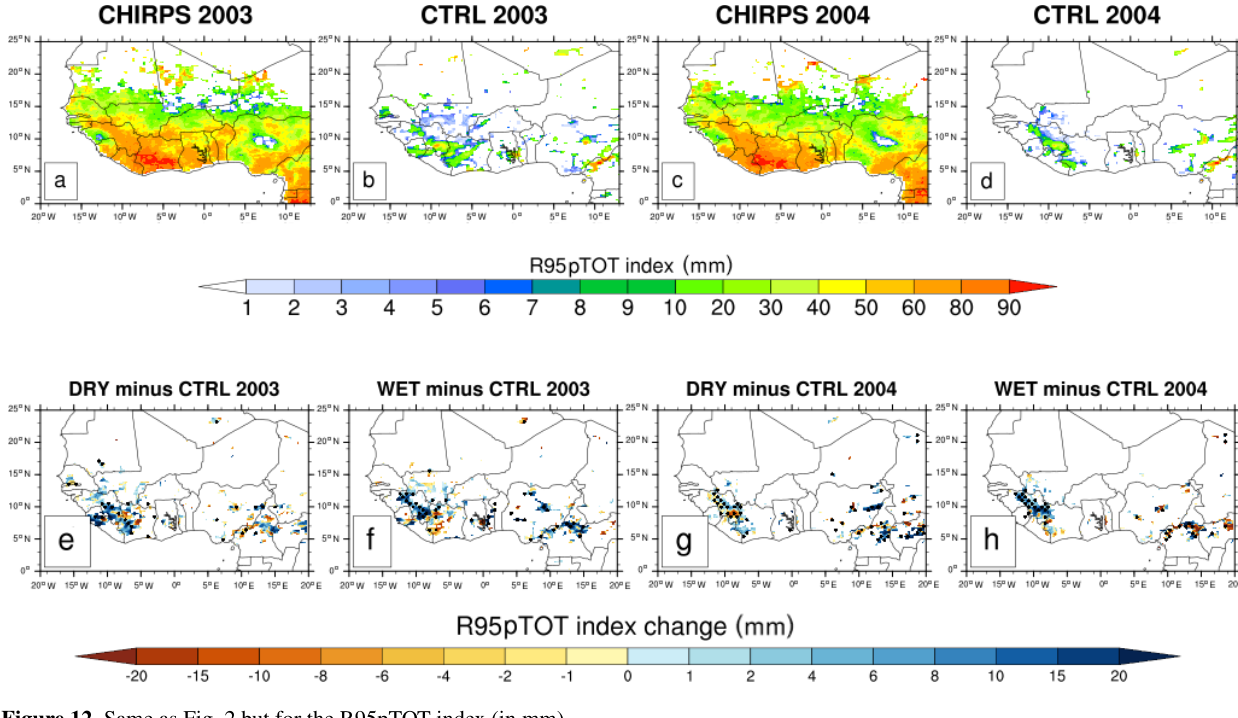
Figure 12. Same as Fig. 2 but for the R95pTOT index (in mm).